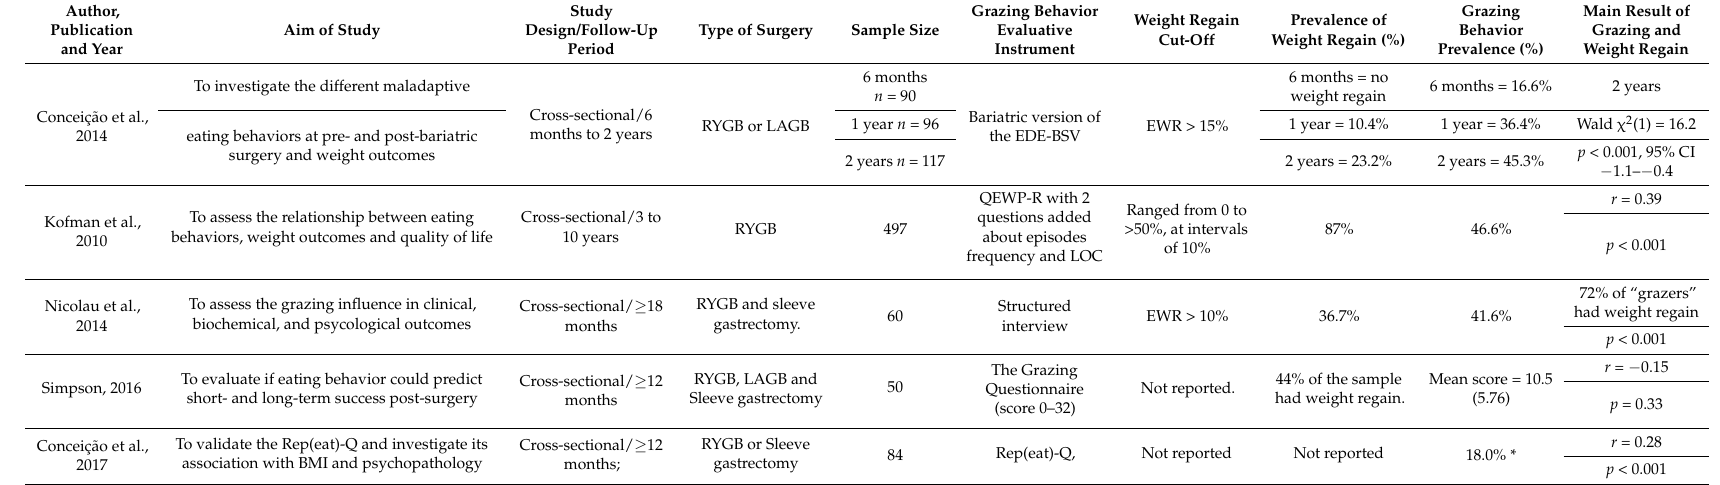
Table 1. Summary of characteristics and outcomes of the included